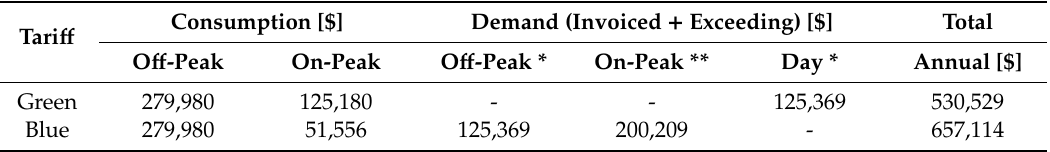
Table 10. Main results for Scenario